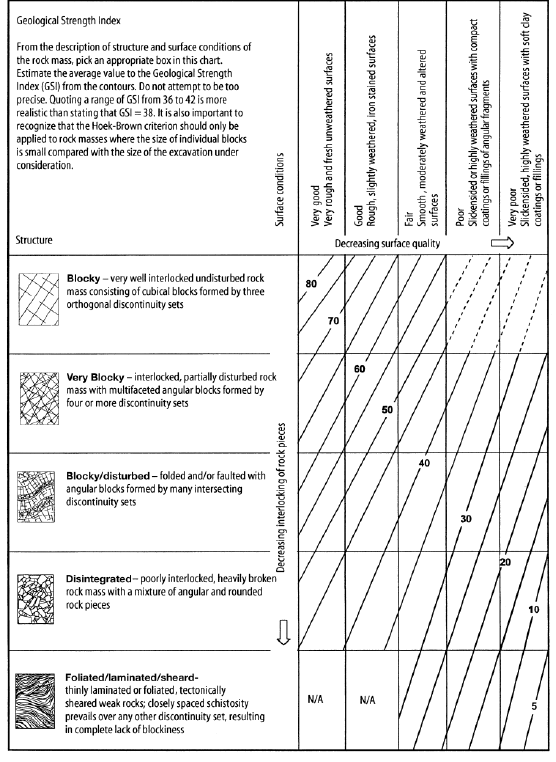
Figure A2. GSI chart for jointed rock masses [22].